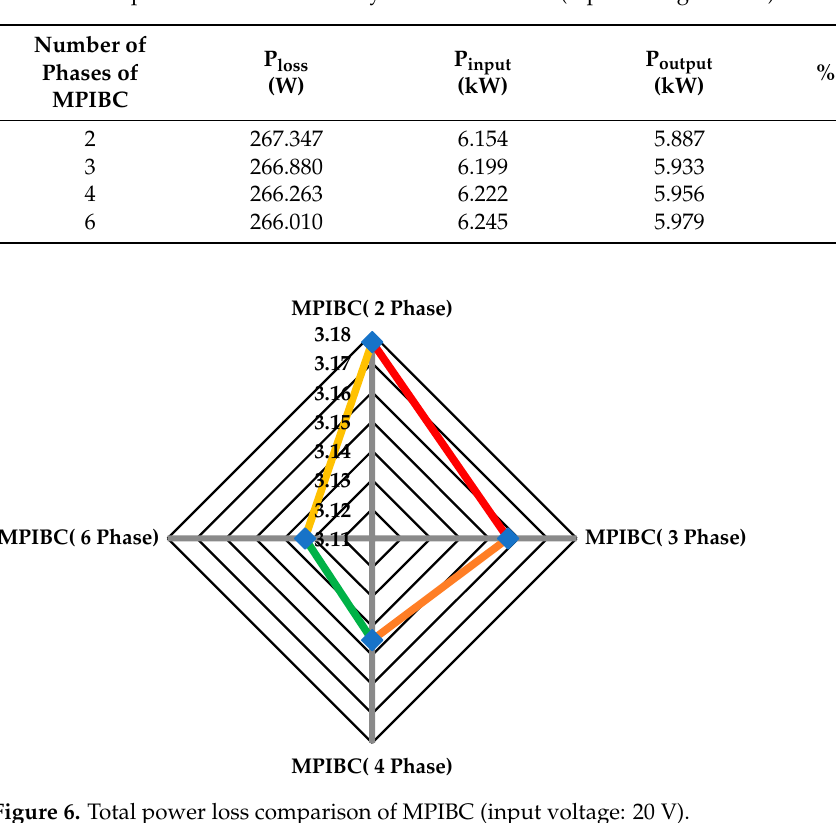
Table 8. Total power loss and efficiency values of MPIBC (input voltage: 200 V).